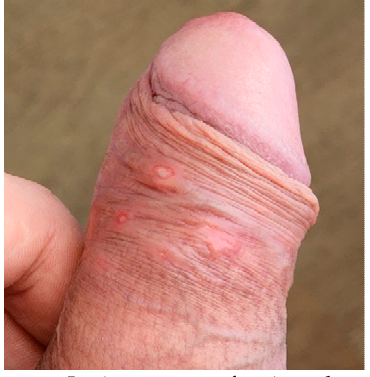
Figure 2. Lesions aspect after 1 week.